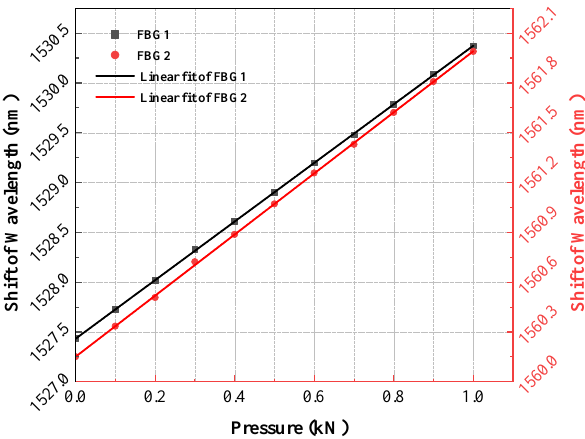
Figure 3. The test data of spoke-type fiber Bragg grating stress